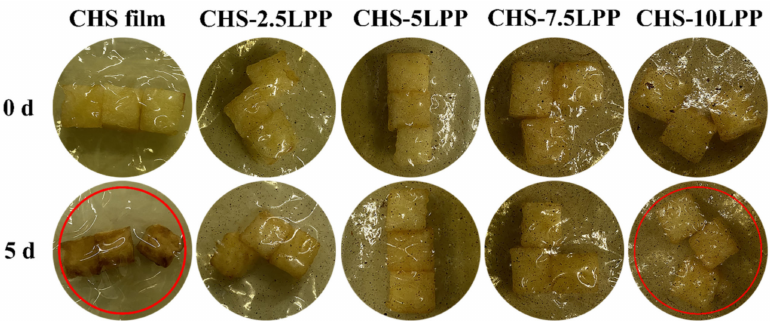
Figure 24. Fresh cut apples stored in chitosan and various concentration of LPP packages after 5 days [70].